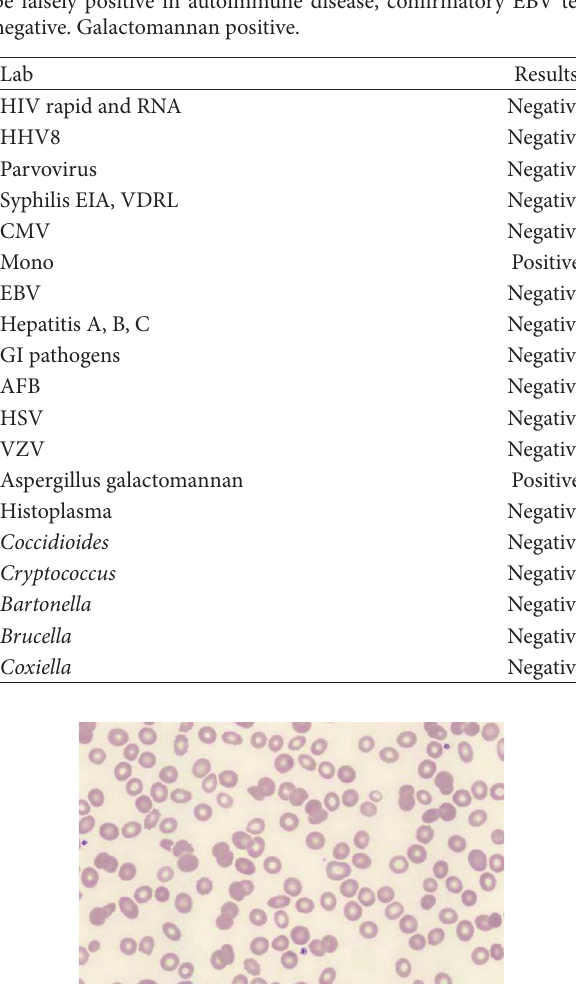
Table 1: Basic lab findings on presentation, most significant for elevated LDH and ANC < 100.